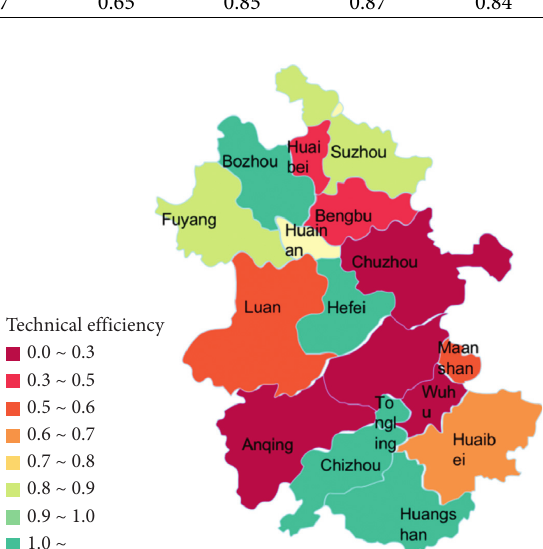
Figure 6: Technical efficiency 2011.